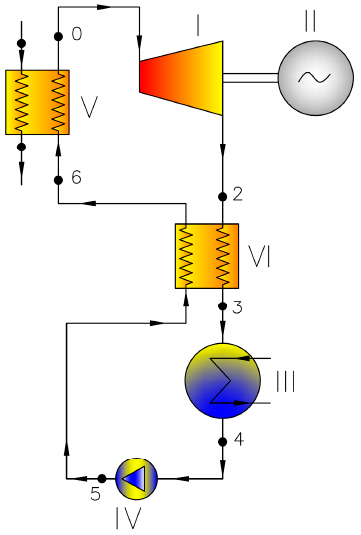
Figure 2. ORC cycle with regenerator; where: I—turbine, II—generator, III—condenser, IV—pump, V—vapor generator, VI—regenerator (Variant 1, 2, 3, and 4).